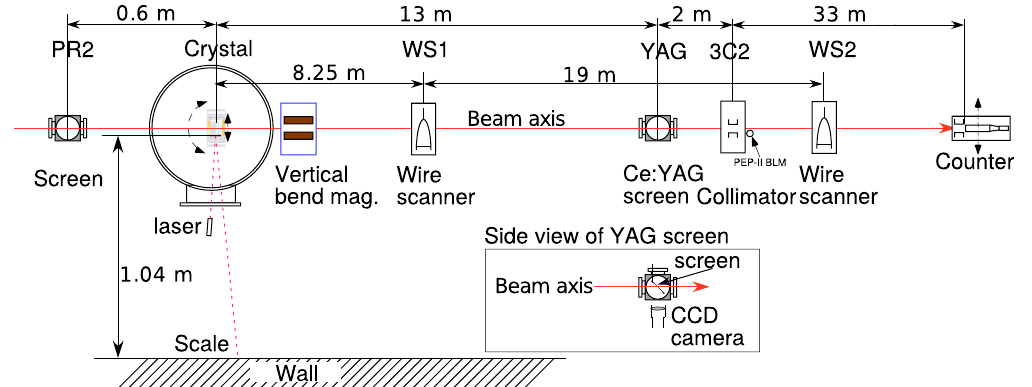
FIG. 1. Sketch of the experimental setup at the SLAC ESTB. Distances are not to scale.